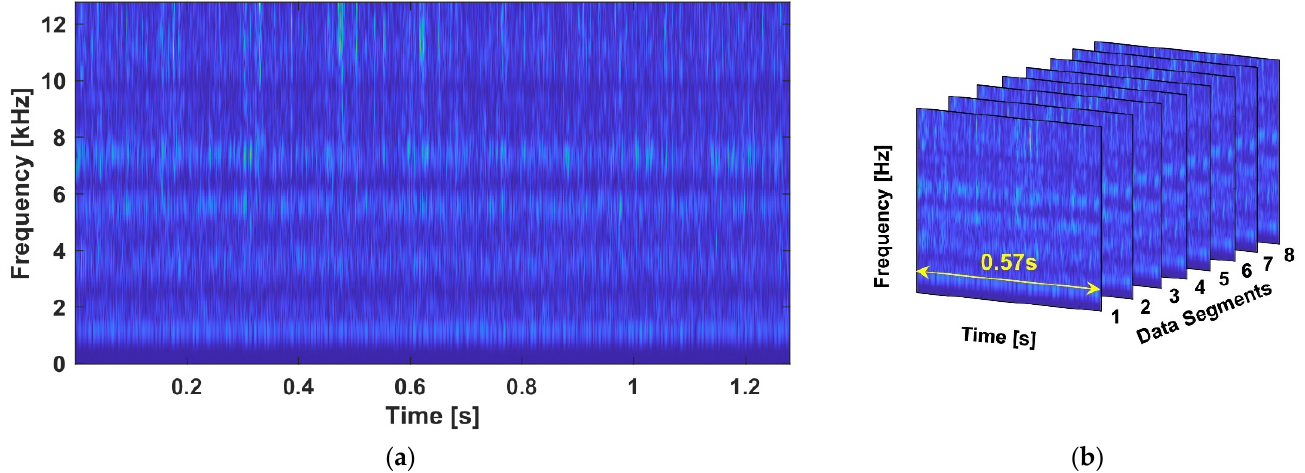
Figure 6. Time − frequency representations of the analysed data: ( a ) STFT spectrogram. ( b ) Time − frequency tensor reorganized from the spectrogram segments, y ∈ R 256 × 14640 × 8 Setting the segmentation length to 20 times of rotation periods, i.e., 20𝑓 (cid:3046) /𝑓 (cid:3045) ≈ 14640 (0.57 s), the frequency bins of STFT as 256, and the number of segments as 𝑆 = 8 (𝐼 (cid:2871) = 1𝑆 = 8) , the TF tensor in Case A, 𝓨 ∈ ℝ (cid:2870)(cid:2873)(cid:2874)×(cid:2869)(cid:2872)(cid:2874)(cid:2872)(cid:2868)×(cid:2876) , could be constructed according to the